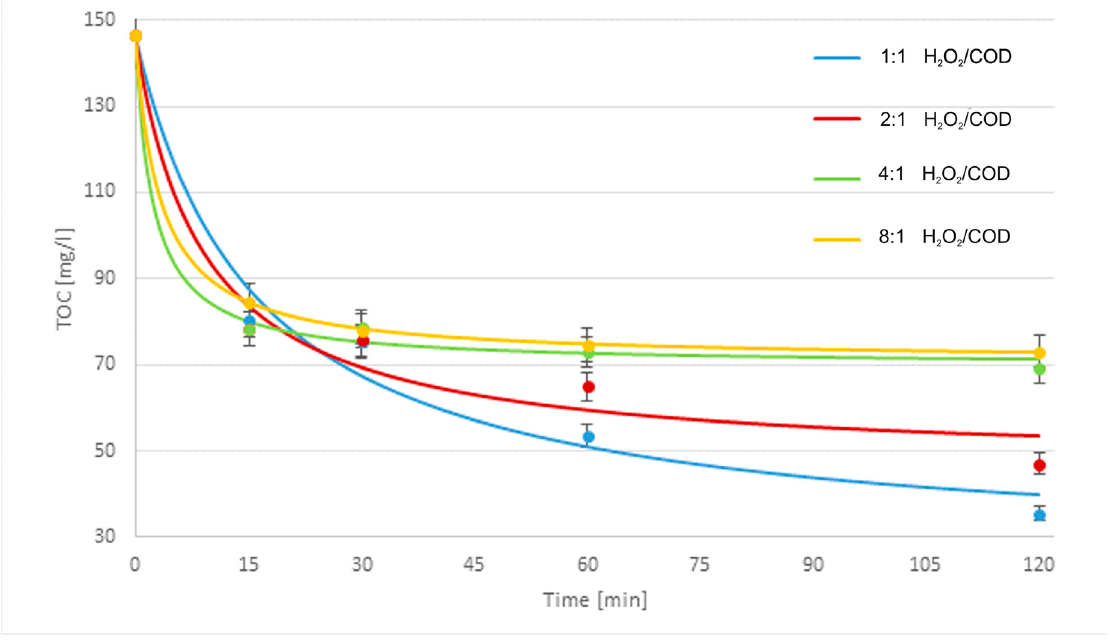
Figure 2. Cosmetic wastewater treatment results, modified 2nd ‐ order kinetic model matching results, light/Fe 3 O 4 /Fe 0 /H 2 O 2 process with 250/750 mg/L Fe 3 O 4 /Fe 0 reagent doses, and different H 2 O 2 /COD ratios.